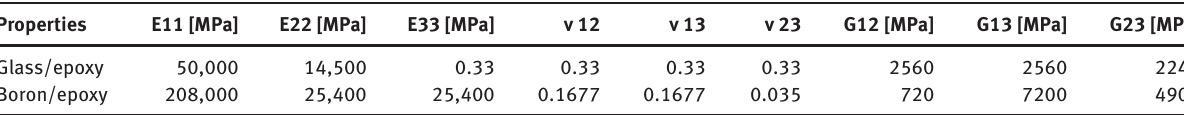
Table 1: Mechanical properties of composites.